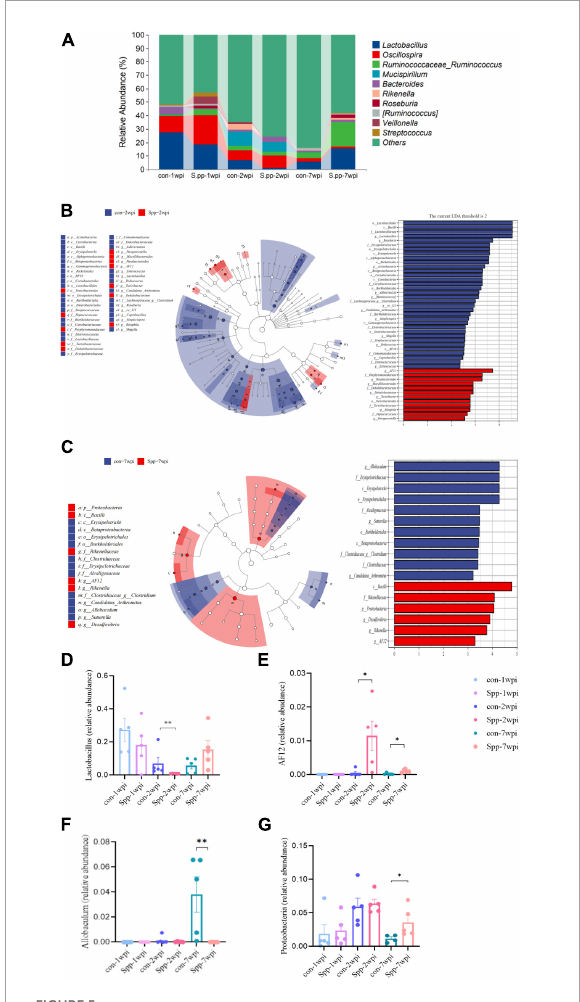
FIGURE5 Effects of neonatal S. pneumoniae infection on gut microbial composition. (A) Relative abundances at the genus level of the mock-infected control and neonatal S. pneumoniae infected ( S . pp) groups in the breastfeeding period (1 wpi), infancy (2 wpi), and adulthood (7 wpi). (B) LEfSe analysis based on the samples of the control and S . pp groups in infancy in various abundant taxa. The left panel shows the cladogram and the right panel shows the linear discriminant analysis (LDA) score (LDA > 2 shown in the Figure) for indicator taxa of the control and S . pp groups ( P < 0.05). (C) LEfSe analysis based on the samples of the control and S . pp groups in adulthood in various abundant taxa. (D) Relative abundance of the genus Lactobacillus was significantly decreased in infancy ( ∗∗ P < 0.01, con-2wpi vs. Spp-2wpi); (E) Relative abundances of the genus AF12 were significantly increased in infancy and adulthood ( ∗ P < 0.05, con-2wpi vs. Spp-2wpi, con-7wpi vs. Spp-7wpi; (F) Relative abundance of the genus Allobaculum was significantly reduced in adulthood ( P < 0.01); (G) Relative abundance of the